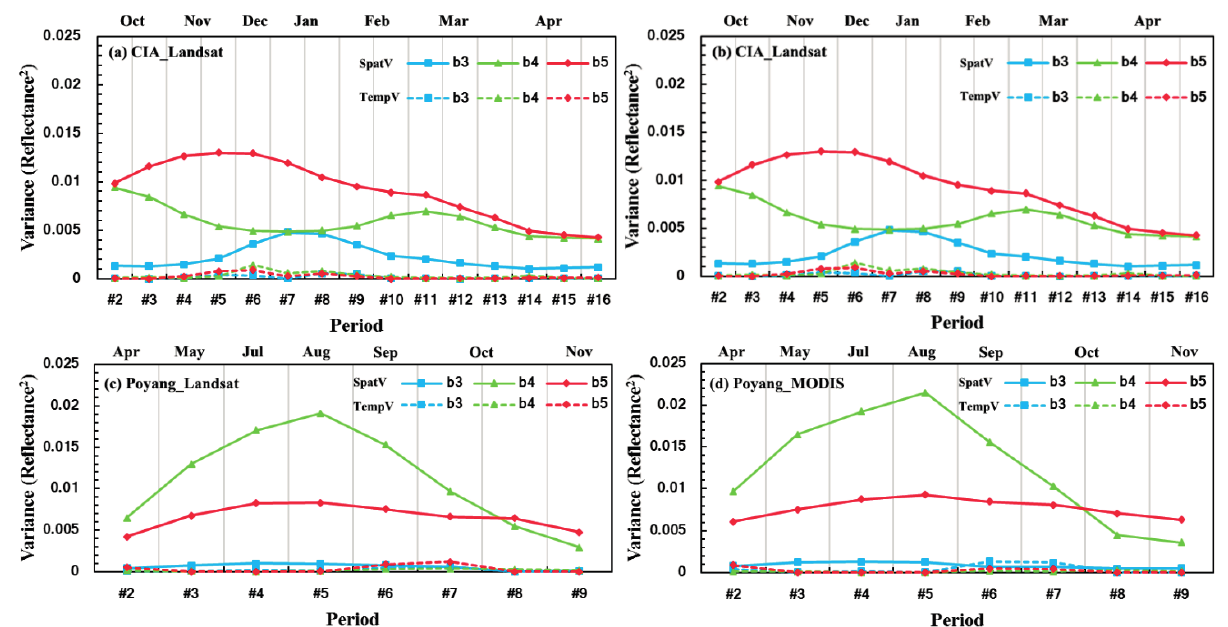
Figure 12. At the CIA ( a , b ) and Poyang Lake sites ( c , d ), changes in the spatial (SpatV) and temporal (TempV) variance over time at the Landsat (a,c); and MODIS (b,d) resolutions.